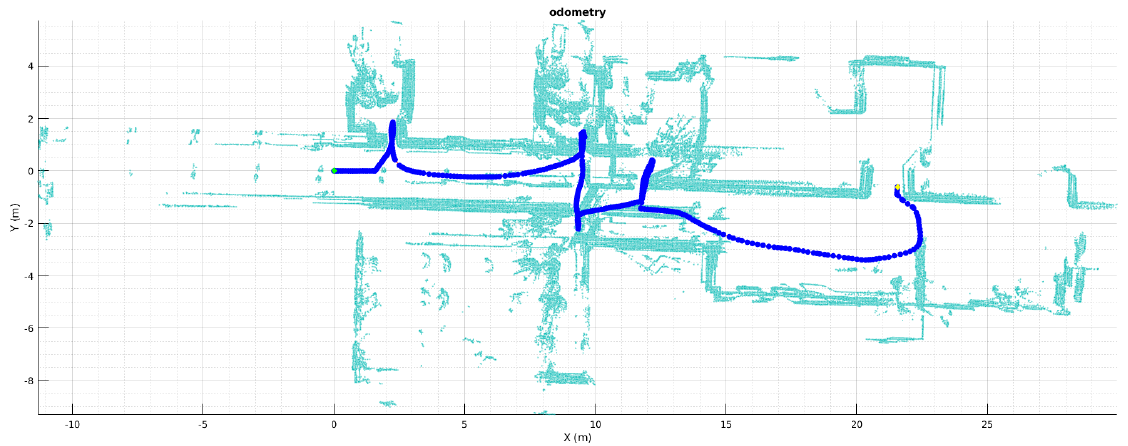
Figure 2. Map built based on robot